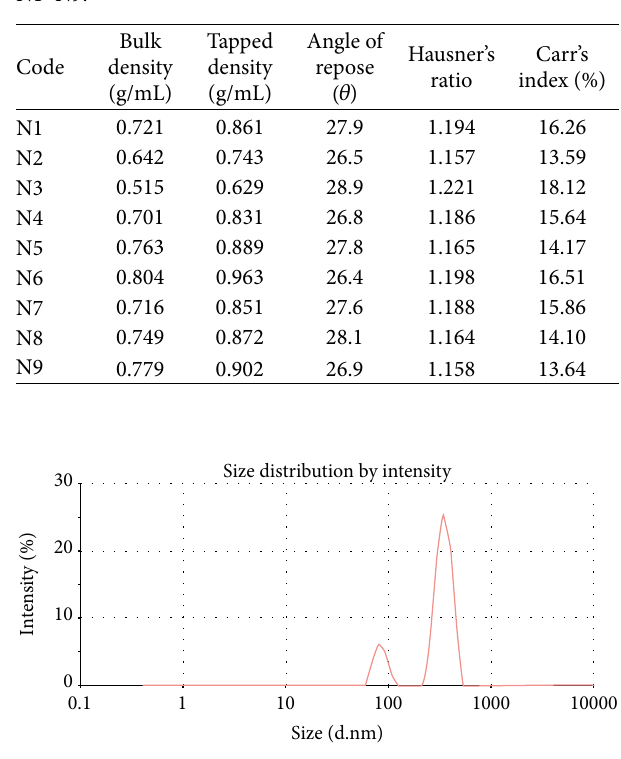
Table 3: Results of micromeritics properties of formulations N1–N9.